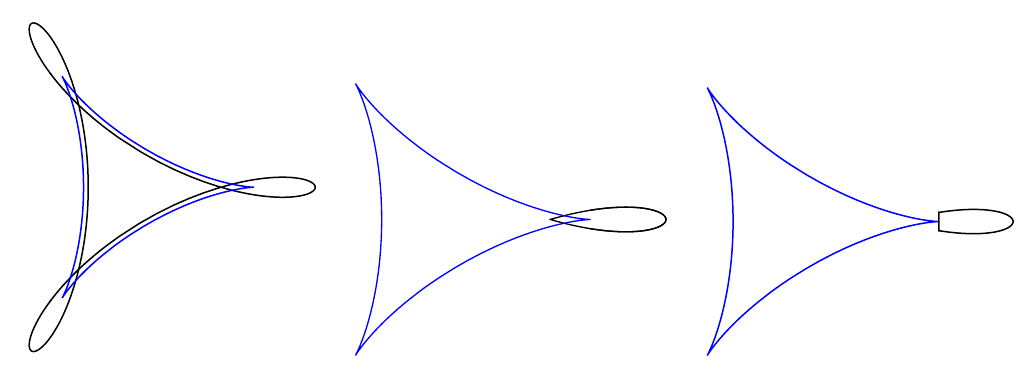
Figure 6. In each panel, the blue triangular-shaped curve is (a c -slice of) the elliptic umbilic caustic. In the leftmost figure, the black curve comprises all source positions with at least one image with (unsigned) magnification ˜ µ , for some fixed value of ˜ µ . In the large magnification limit, the magnification of one of the images in the two-image region dominates that of the other, in which case the loops enclosing each cusp in the leftmost panel approach the regions A , B , and C in Figure 2. The closed black curves in the middle and rightmost figures bound the areas A , B , and C from above and below. It can be shown that these two area bounds, which are functions of µ and c in general, both scale to leading µ − 2.5 , where µ is the total unsigned magnification of a source in the two-image order in µ as ∼